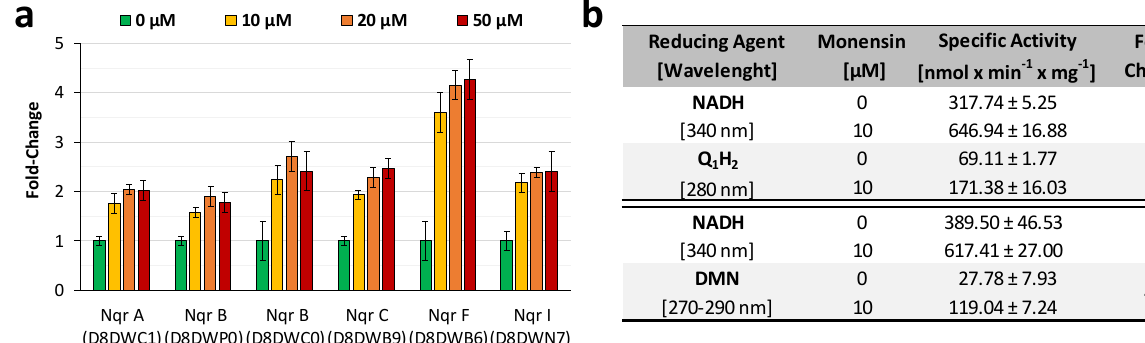
Figure 5. Na + -translocating NADH:quinone oxidoreductase (NQR) abundance and activity under presence or absence of monensin. ( a ) Bar plot with mean abundance (n = 6) of NQR subunits including their standard deviation represented as error bars. The Uniprot ID is given in brackets. ( b ) Mean specific activity (n = 3) and standard deviation of NQR. Oxidation NADH, and formation of ubiquinone (Q 1 H 2 ) and menaquinole (DMNH 2 ) were followed with membranes of P. bryantii B 1 4.